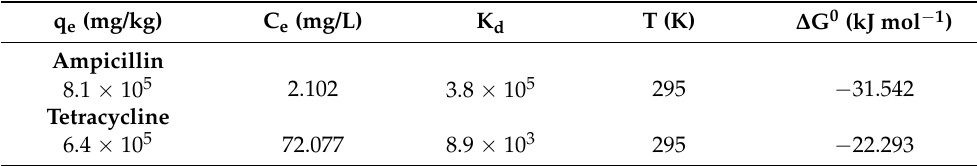
Table 2. The values of the distribution coefficient and the change in Gibbs free energy of the ampicillin and tetracycline sorption by zinc oxide